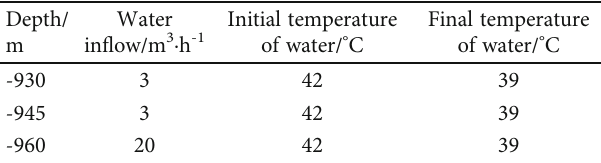
Table 2: Electromechanical equipment parameters in each sub- level.